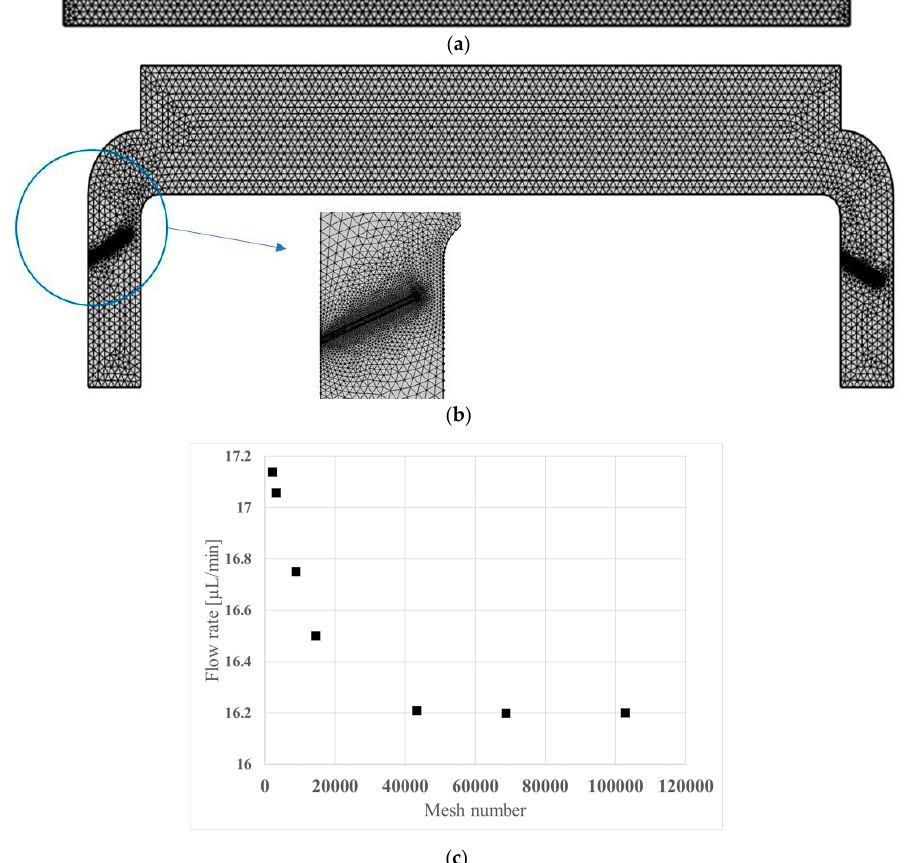
Figure 5. ( a ) Applied meshes to the piezoelectric component ( b ) Applied tetrahedral elements in rest of the simulated models, ( c ) Variation of flow rate for different mesh numbers .